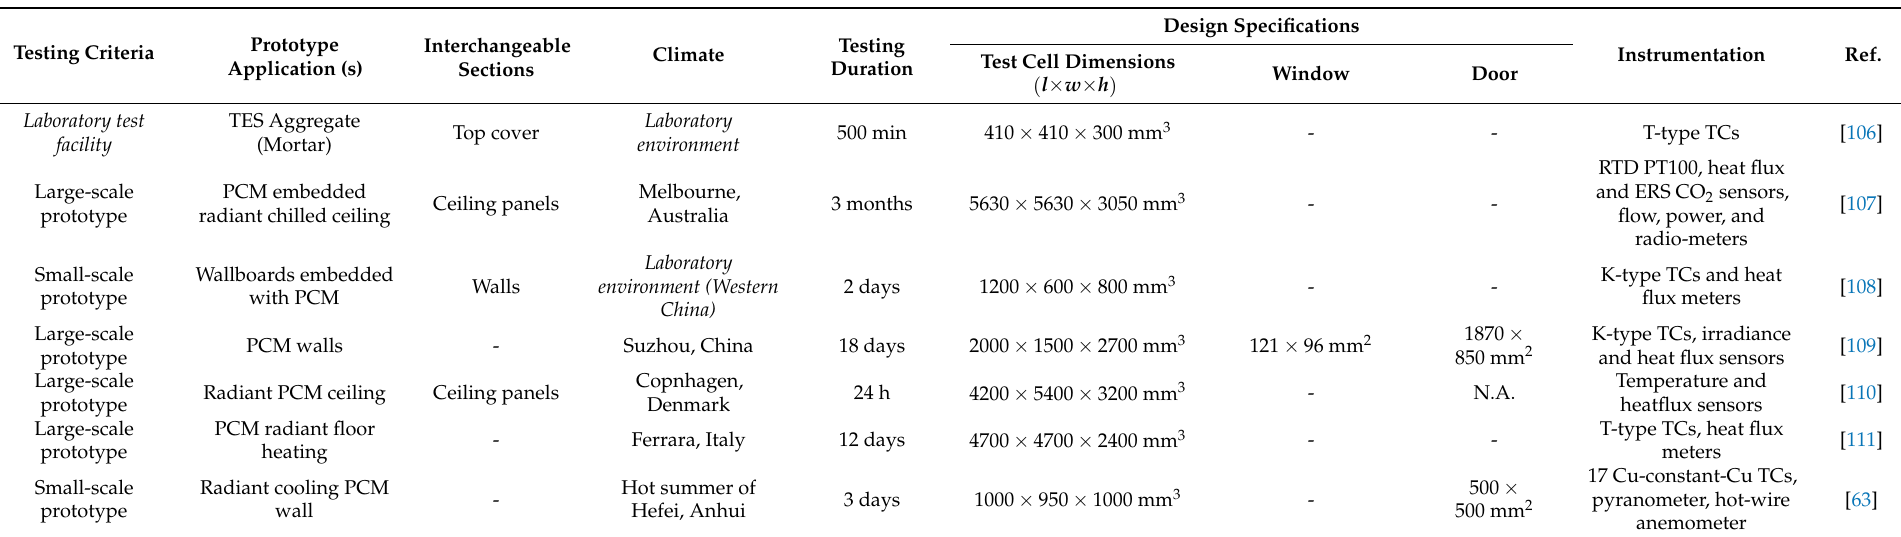
Table 3. Summary of literature prototype designs and specifications for PCM building